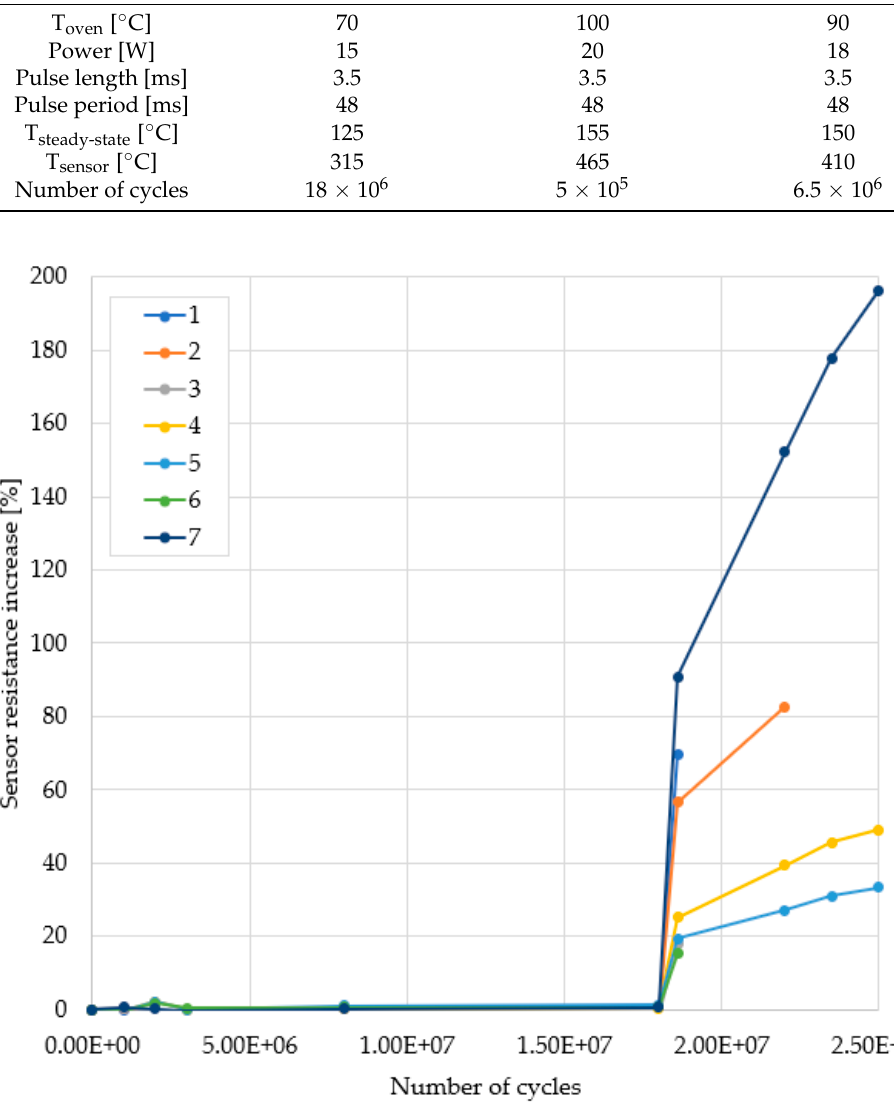
Figure 13. Sensor response during initial tests.